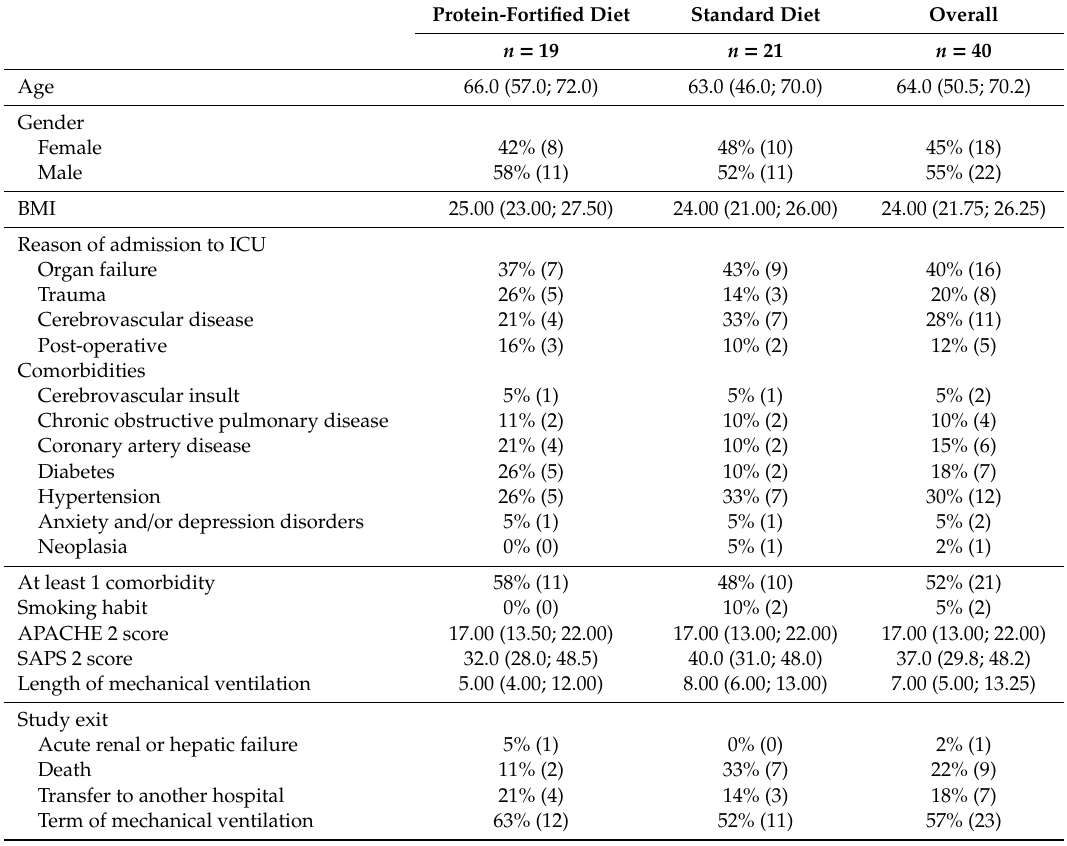
Table 1. Characteristics of the patients at randomization (day 0).